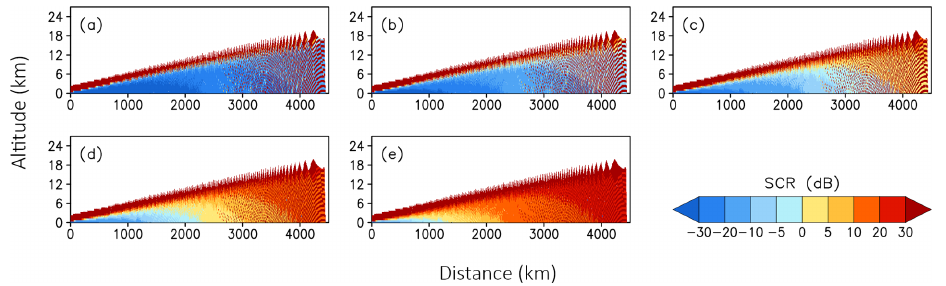
Figure 6. Signal-to-clutter ratio (SCR) in measuring five precipitation intensities at (a) 20, (b) 30, (c) 40, (d) 50, and (e) 60dBZ as a function of the distance from the nadir (km). It is assumed that altitudes lower than 2km are filled with homogeneous precipitation.